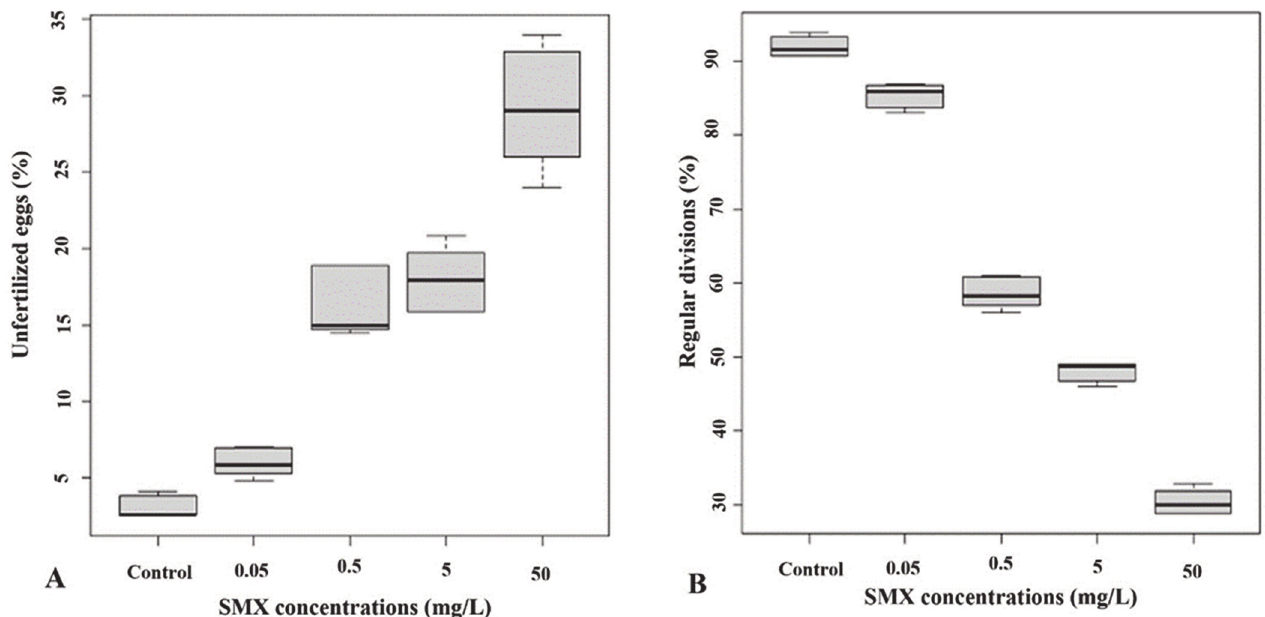
Figure 2. Percentage of unfertilized eggs ( A ) and embryos’ regular divisions ( B ) considering division stages with a number of blastomeres ≥ 16 after preventive exposure (PE) of the gametes to the sulfamethoxazole solutions. Black bars represent medians.